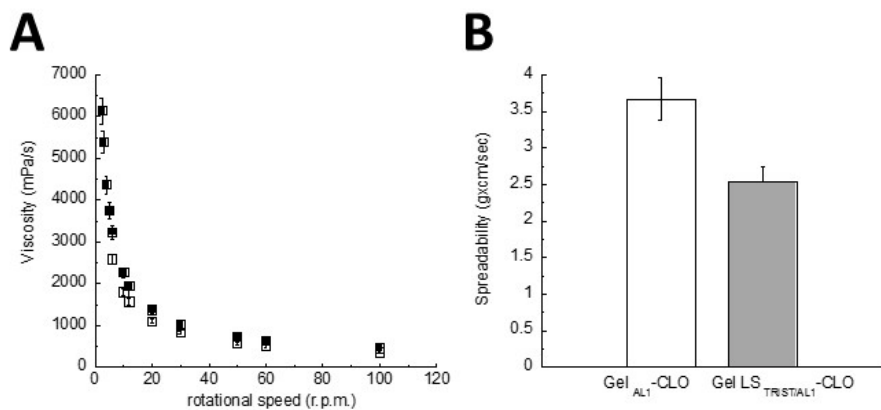
Figure 3. ( A ) Viscosity of Gel LS TRIST/AL1 -CLO ( ■ ) and Gel AL1 -CLO ( □ ) as a function of the rotational speed; ( B ) Spreadability behavior of the indicated gels. The spreadability was calculated as reported in Section 2.2.7 (Equation (3)). Gel acronyms are reported in Table 2.